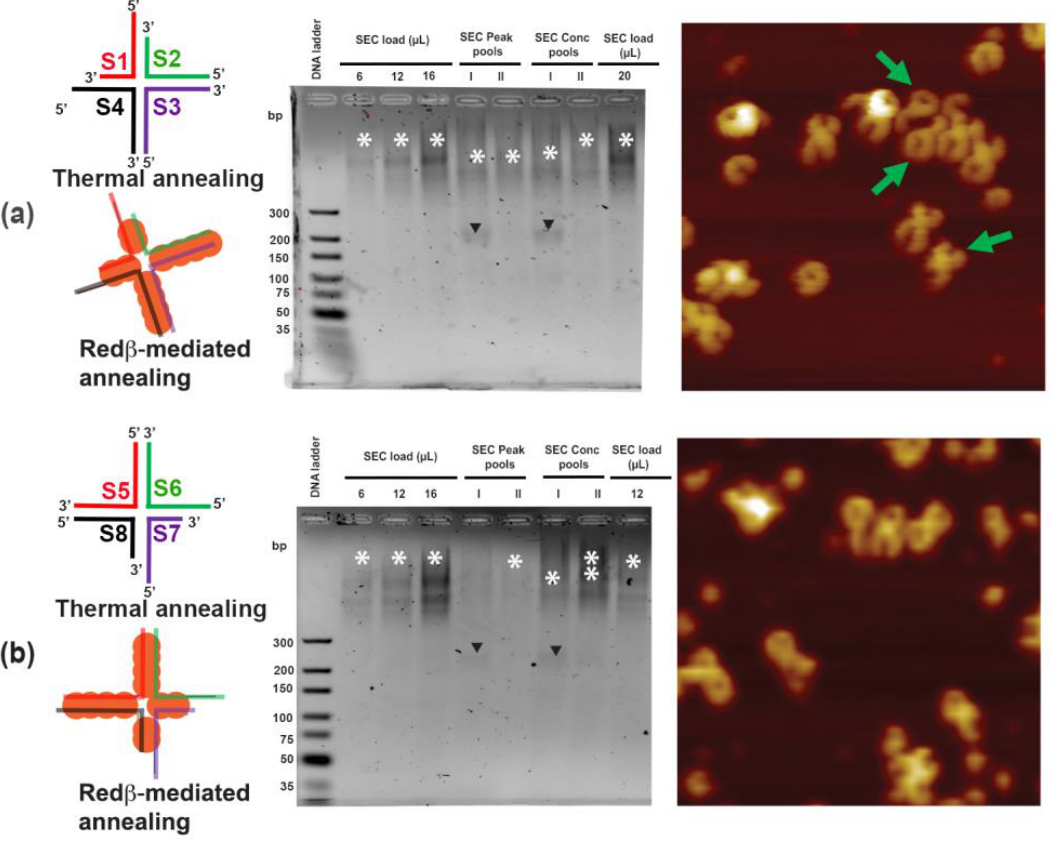
Figure 6. The schematic structures show the ( a ) S1S4 and ( b ) S5S8 HJ junction designs assembled by thermal and Redβ-mediated annealing. The corresponding sodium borate agarose gel analyses were conducted with the input and the pooled fractions after SEC, as explained in Figure 5. The downward-facing arrowheads in the gel image indicate the free ssDNA, while the asterisks indicate the HJ structures. The AFM images of Peak I (see Figure 5) were recorded after SEC purification. The AFM images show completely formed HJ structures with the green arrows indicating HJ structures with one arm missing. The AFM images have a size of 300 × 300 nm² and a height scale of 4 nm. For hierarchical assembly, Peak I and Peak II from the S1S4 assembly were mixed with the corresponding Peak I and Peak II from the S5S8 assembly, respectively. Four discrete bands can be seen in the lane corresponding to the concentrated Peak I of S1S4 and S5S8 HJ structures after SEC (gel image in Figure 7, white asterisks). Surprisingly, the Peak II combination did not show any hierarchical assemblies (see Figure 7). Therefore, the Peak I sample was used for AFM imaging.